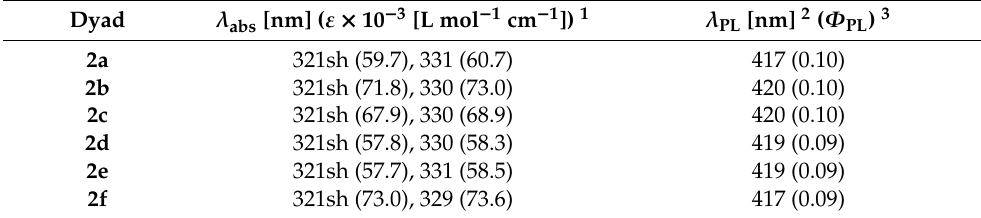
Figure 4. ( a ) UV–vis absorption (dashed line) and PL spectra (solid line) for 2a – f in CH 2 Cl 2 . Concentration: 1.0 × 10 − 5 mol L − 1 for UV–vis and 1.0 × 10 − 6 mol L − 1 for PL measurements. Excited at 330 nm light. ( b ) Commission Internationale de l’Eclairage (CIE) color diagram for PL of 2a – f in CH 2 Cl 2 . Table 2. Photophysical parameters of 2a – f in CH 2 Cl 2 solution.